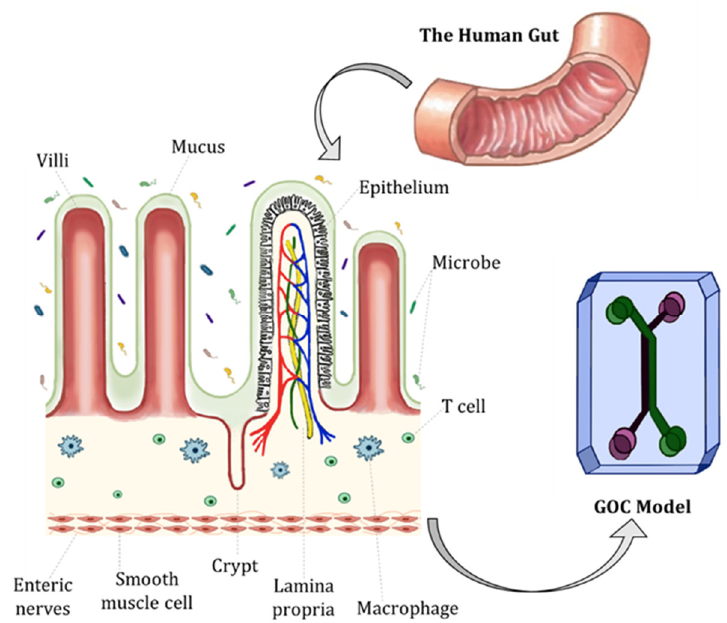
Figure 2. The schematic representation of the human gut in a GOC model. The human gut is covered with finger-like villi structures and invaginations called ‘crypts of Lieberkühn’.